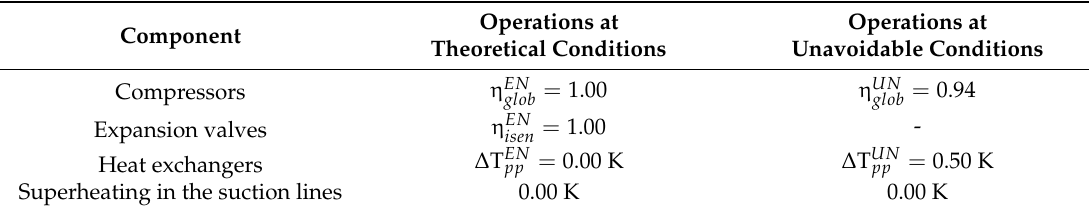
Table 6. Assumptions adopted to implement the advanced exergy analysis